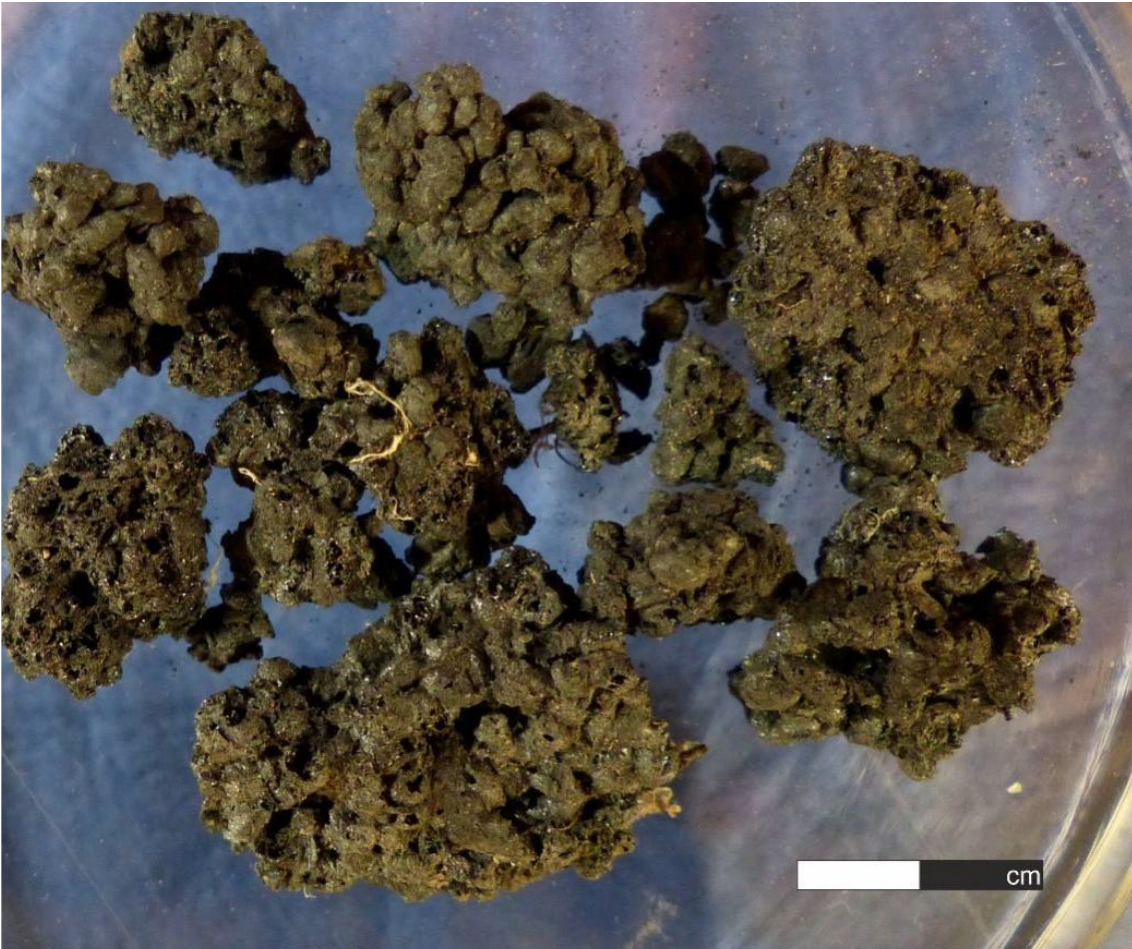
Figure 7. Cereal-based food remains from Archontiko Giannitson (after Valamoti 2018, ERC